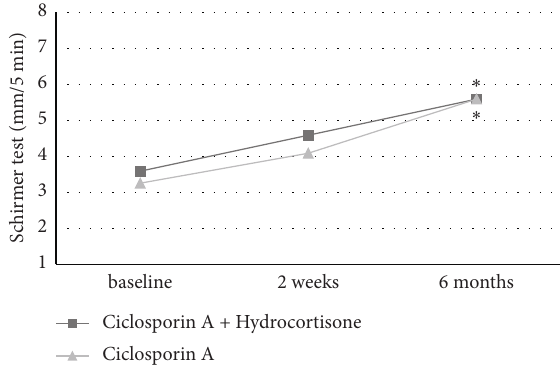
Figure 2: Tear breakup time (BUT) in both treatment groups at baseline, after 2 weeks, and after 6 months of treatment. Significant differences to baseline are marked with ∗ .